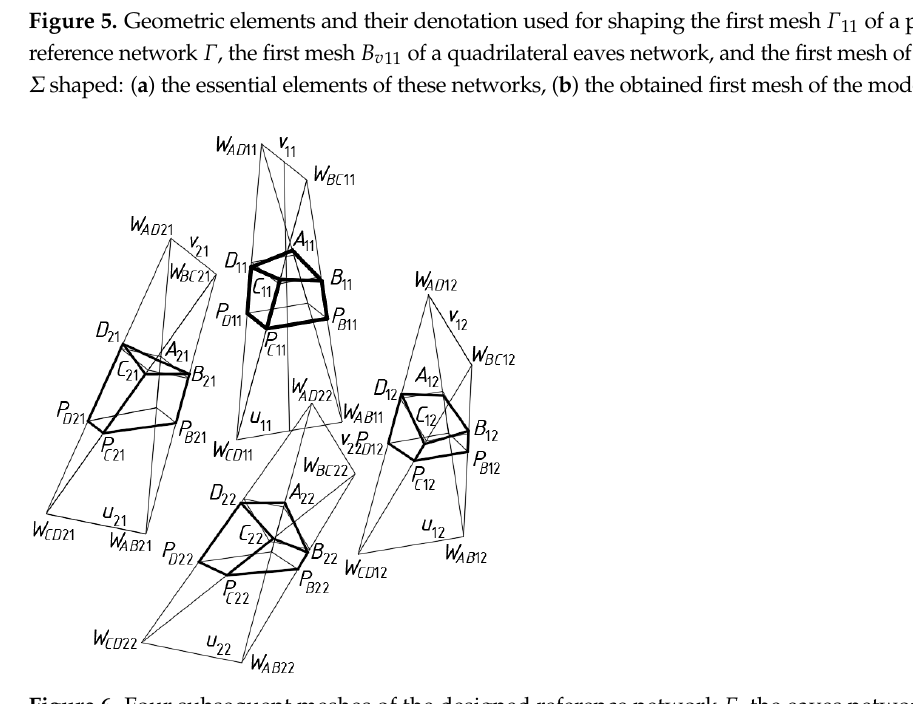
Figure 6. Four subsequent meshes of the designed reference network Γ , the eaves network B v , and the model Σ . The location of the vertex W BC 12 is determined so that it is contained in the plane ( y , z ), distant from W BC 11 by the adopted value of d v 12 and distant from the axis u 11 by the height d BC 12 of the triangle W BC 12 W CD 12 W AB 12 measured from W BC 12 , where W BC 12 W CD 12 W AB 12 should be congruent to W BC 11 W CD 11 W AB 11 . The above activities lead to the creation of the ( b ) Figure 7. Subsequent meshes positioned in two orthogonal directions of the designed reference net- work Γ , the eaves network B v , and the complex structure Σ : ( a ) the first orthogonal direction, and ( b ) two orthogonal directions. It is more convenient to control the shape of Σ when the proportions dd BC 12 = d v 12 /d v 11 and dd BC 12 = d BC1 2 /d BC 11 are used instead of the above-mentioned distances. D BC 12 is the